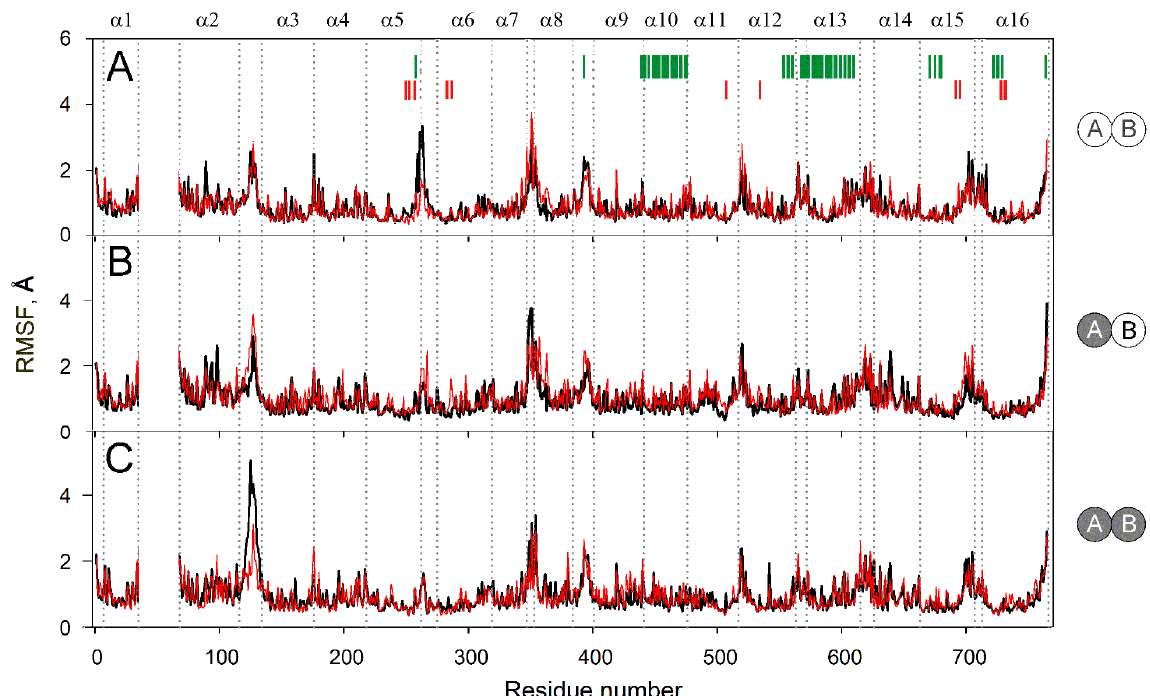
Figure 4. Residue sidechain fluctuations (RMSF) in the MD-simulated subunit structures of the IDP complexes of Vr-mPPase of different stoichiometry. The data were collected during 160–200 ns of the simulation. IDP-free and IDP-bound subunits within the dimer are shown as open and closed circles, respectively, on the right-side schemes for panels ( A – C ). Black and red lines refer to subunits A and B, respectively. Other details of the structures and notations are found in the Figure 2 legend.